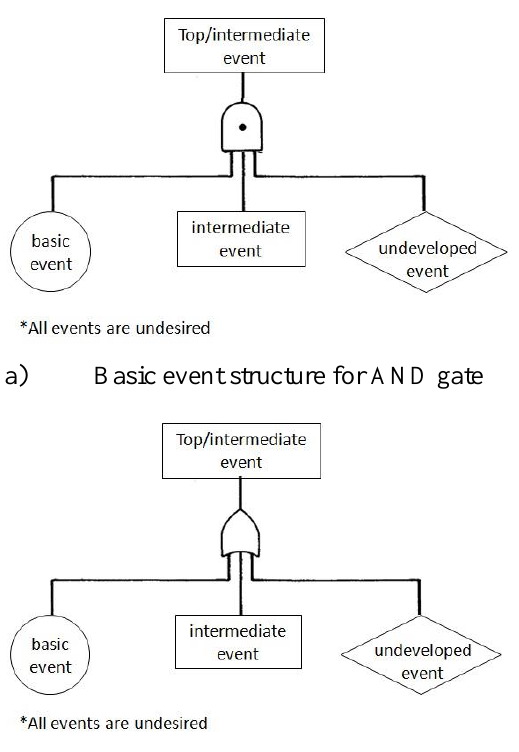
Figure 1 . Basic event structure of fault tree